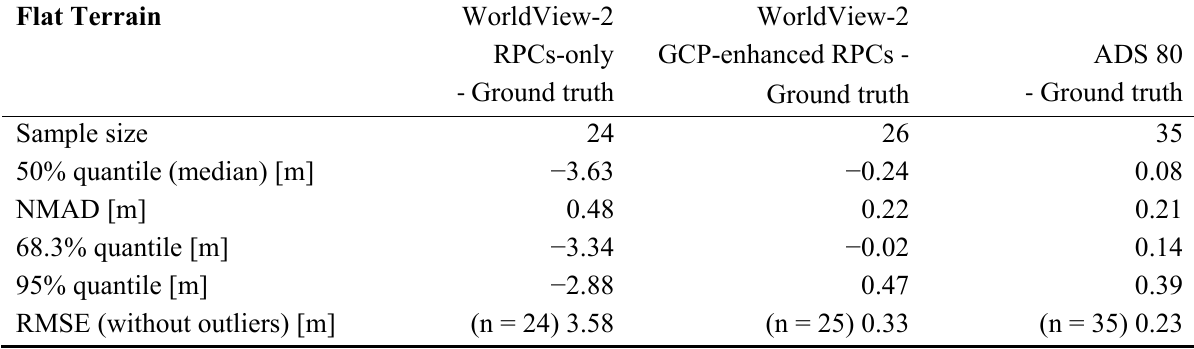
Table 3. Robust vertical accuracy measures of the digital surface models based on ground check points in flat terrain.